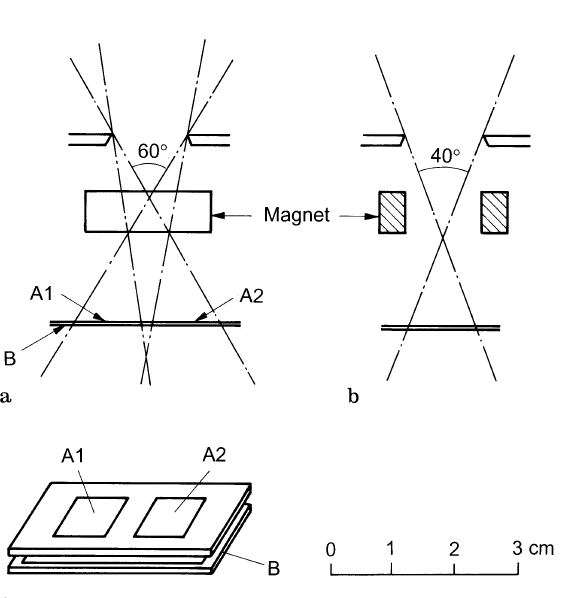
Fig. 1. a Schematic of one LION sensor, showing the ‘2 in 1’ telescope configuration and deflection magnet; b as above, seen rotated through 90 ° ; c schematic of the LION detector stack